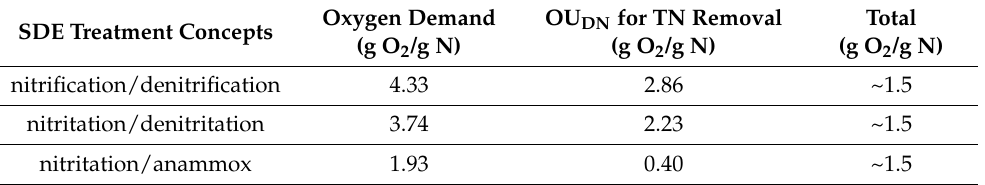
Table 1. Oxygen demand and oxygen utilisation for carbon removal for denitrification (OU DN ). SDE Treatment